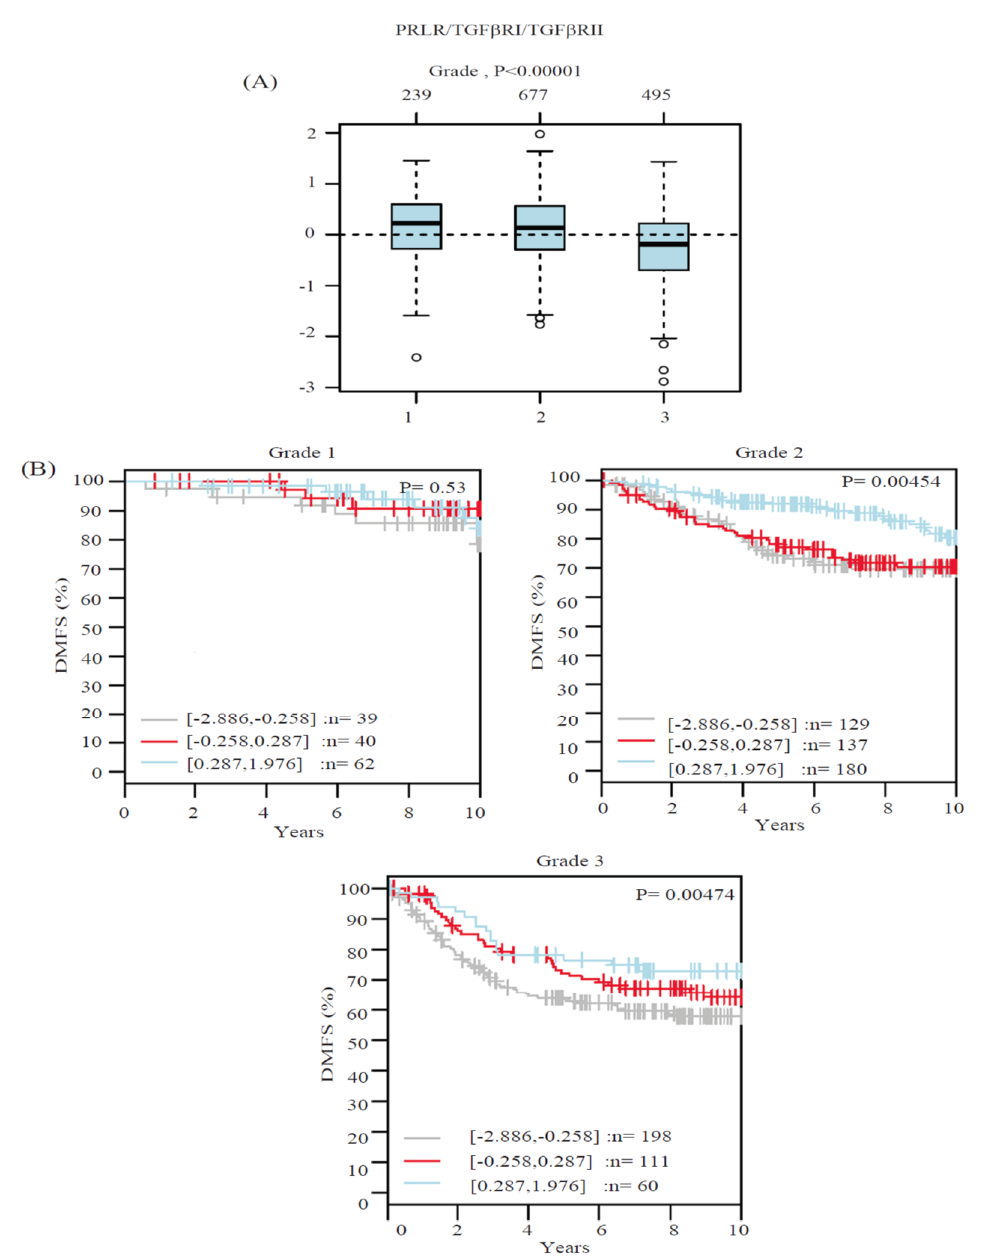
Figure 3. PRLR/TGF β RI/TGF β RII gene signature and its association with tumor grade and patient outcome. ( A ) Boxplot of PRLR/TGF β RI/TGF β RII gene signature in 1881 breast cancer cases from the GOBO database stratified according to histological grade. The band inside the box represents the median. The top and bottom of the box indicate the distance between quartile 1 (Q1), quartile 3 (Q3) and 1.5 times the interquartile range. In addition, the circles (when present) indicate the outliers. ( B ) PRLR/TGF β RI/TGF β RII gene signature and its association with patient outcome using distant metastasis-free survival (DMFS) as an end point in different tumor grades using 1881 breast cancer cases from the GOBO database.